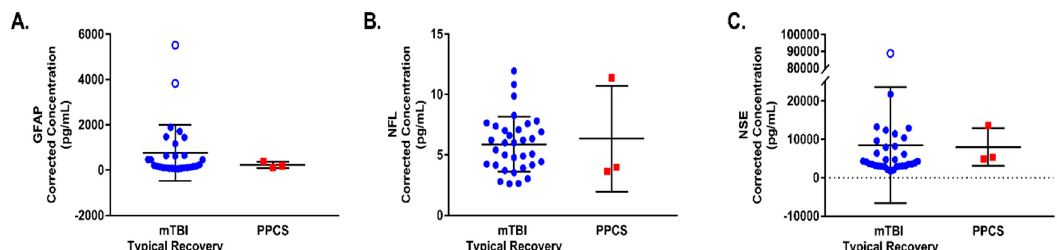
Figure 4. Scatterplots depicting the corrected concentrations of blood-based biomarkers ( A ) GFAP, ( B ) NFL and ( C ) NSE measured from blood samples obtained upon patient presentation to the ED. Mean and standard deviation are shown for mTBI typical recovery and PPCS groups for all outcomes assessed. Outliers are denoted by empty circles (mTBI Typical Recovery) and squares (PPCS), which were excluded from OR analyses presented in Table 3.